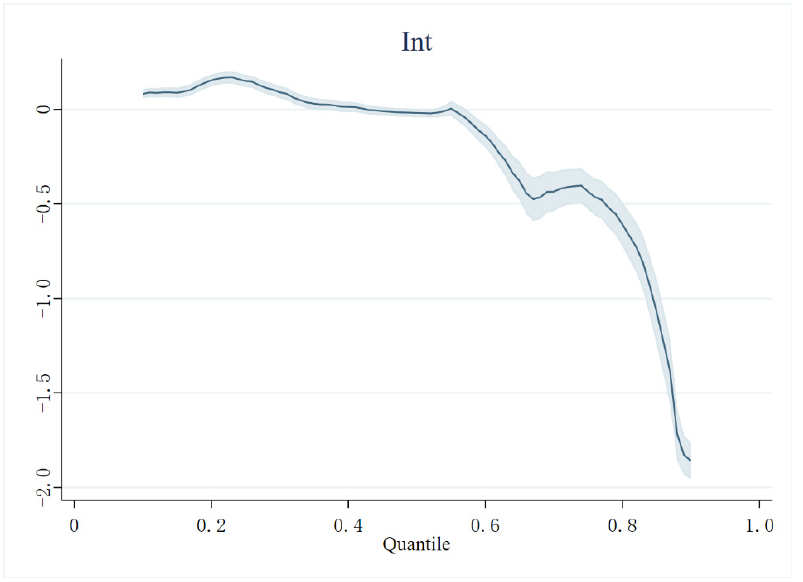
Figure 2. Quantile regression results.